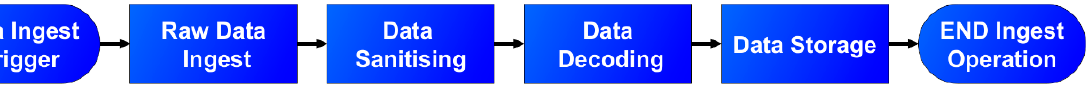
Figure 3. High-level flow diagram representing the behavior of the data integration and manage- ment system.